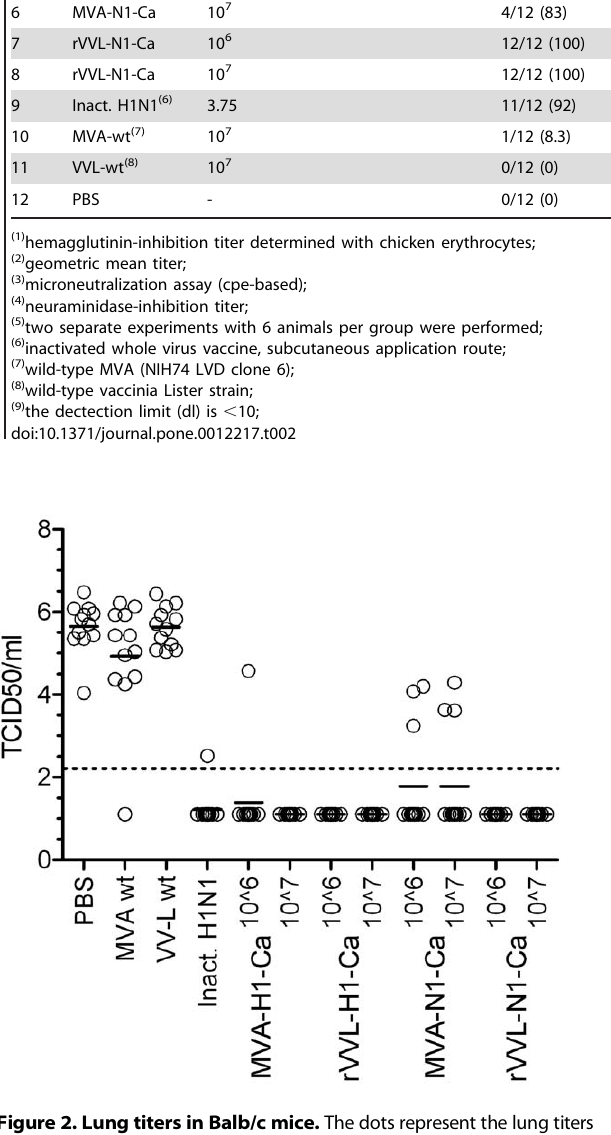
Figure 2. Lung titers in Balb/c mice. The dots represent the lung titers of individual mice vaccinated with the different experimental vaccines or control preparations. Mice vaccinated with the controls (PBS, wild-type MVA (MVA wt) or Lister (VV-L wt) were not protected showing average log10 TCID50 titers of 5.2, 4.9 and 5.4, respectively. Mice vaccinated with inactivated vaccine (inact. H1N1), or two different doses (10 6 , 10 7 pfu) of MVA-H1-Ca or rVVL-H1-Ca were close to or fully protected. Partial protection was achieved with two dosages of the MVA neuraminidase viruses (MVA-N1-Ca), while full protection was seen with the Lister-based neuraminidase virus (rVVL-N1-Ca). The dotted line represents the detection limit of log 10 2.21. Low titers in range of log10 , 2.21 to 3.0 were confirmed by a passage assay of the lung samples in MDCK